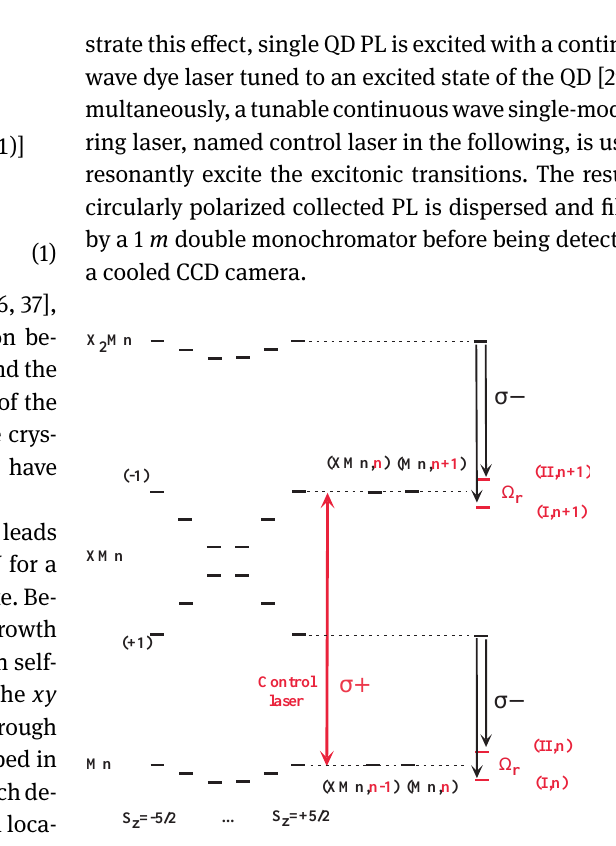
Figure 4: Energy scheme of a Mn-doped QD and formation of light- matter hybrid states by a laser field. In the absence of carriers, the Mn fine structure is dominated by the strain induced magnetic anisotropy which also splits the biexciton states (X 2 Mn). The bright exciton levels (X, with kinetic momentum ±1 ) are split by the ex- change interaction with the Mn (XMn levels). A pump laser tuned to a QD excited state is used to produce PL of any exciton and biex- citon states. The Rabi splitting, (cid:126) Ω r , induced on the Mn state by the control laser (circularly polarized σ + ) can be probed in the PL of the exciton while the splitting of XMn is observed in the PL of the biexciton. (I,n), (II,n), (I,n+1), and (II,n+1) are the optically dressed states produced by the mixing of the uncoupled states (XMn,n-1), (Mn,n), (XMn,n), and (Mn,n+1) where n is the number of photons in the control